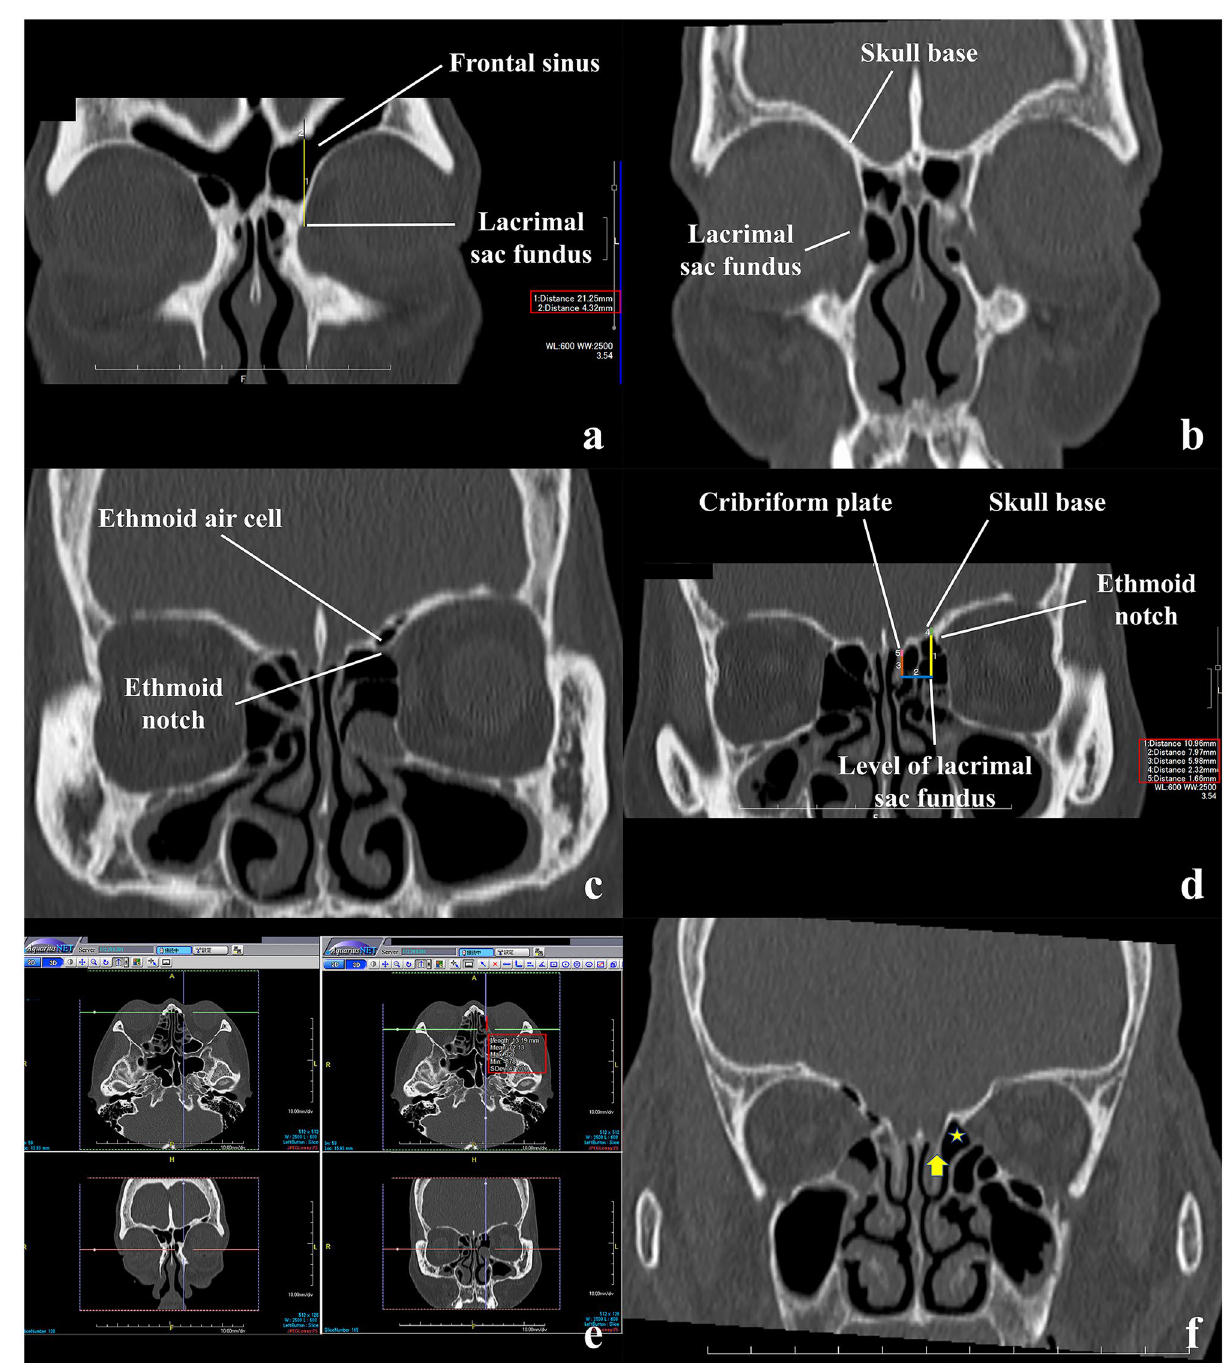
Figure 2. Measurements on computed tomographic (CT) images. The measurement results are surrounded by the red rectangles. ( a , b ) The coronal CT images showing the lacrimal sac fundus (anterior planes). Measurements of the distance between the lacrimal sac fundus and skull base (#1, yellow line) and the thickness of the skull base (#2, black line) in a patient with interposition of the frontal sinus between the lacrimal sac fundus and skull base (frontal sinus interposition) ( a ). No frontal sinus interposition ( b ). ( c , d ) The coronal CT images with ( c ) and without interposition of an ethmoid air cell above the ethmoid notch (ethmoid sinus interposition) ( d , posterior plane). The vertical distance from the level of the lacrimal sac fundus to the skull base (#1, yellow line), the vertical (#3, brown line) and horizontal (#2, blue line) distances from the level of the lacrimal sac fundus to the lateral margin of the cribriform plate, thickness of the skull base at the vertical level of the lacrimal sac fundus (#4, green line), and that of the cribriform plate were measured (#5, pink line) ( d ). ( e ) First, the intersection of the cursor was fixed at the lacrimal sac fundus (left-bottom). The coronal section moved posteriorly until the section showing no ethmoid sinus interposition (right-bottom, posterior plane). The anteroposterior distance of the posterior lacrimal crest from the posterior plane was measured (red line) (right-upper). ( f ) The cribriform plate (arrow) is positioned below the horizontal level of the lacrimal sac fundus